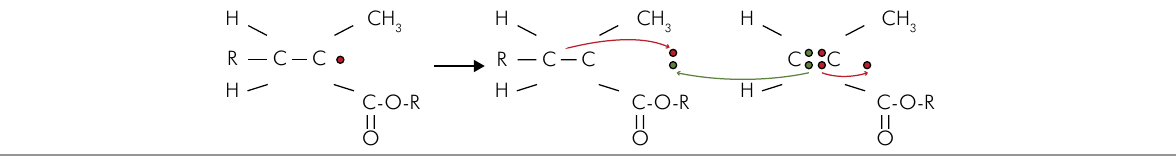
Figure 4. Polymer chain propagation by addition of successive monomer units.